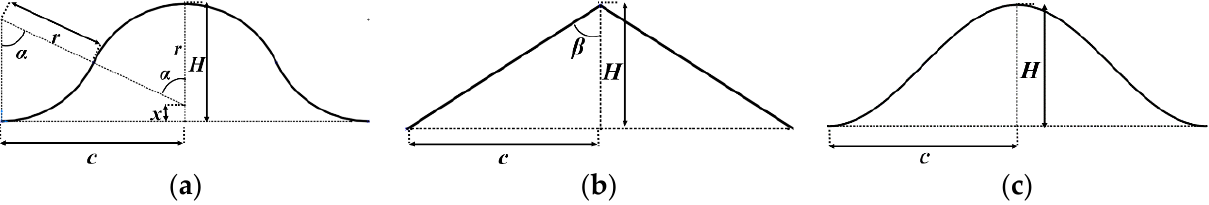
Figure 2. The configurations of different channels. ( a ) Serpentine channel configuration. ( b ) Zig channel configuration. ( c ) Sine channel configuration.